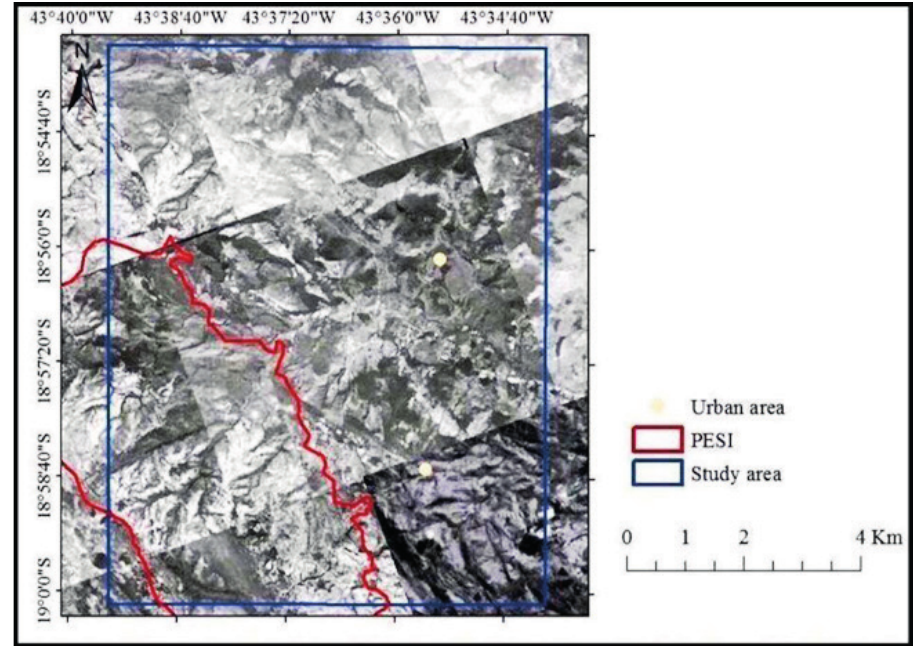
Figure 1 - Mosaic of aerial photographs of the study area including the delimitation of Parque Estadual Serra do Intendente (PESI) in the year